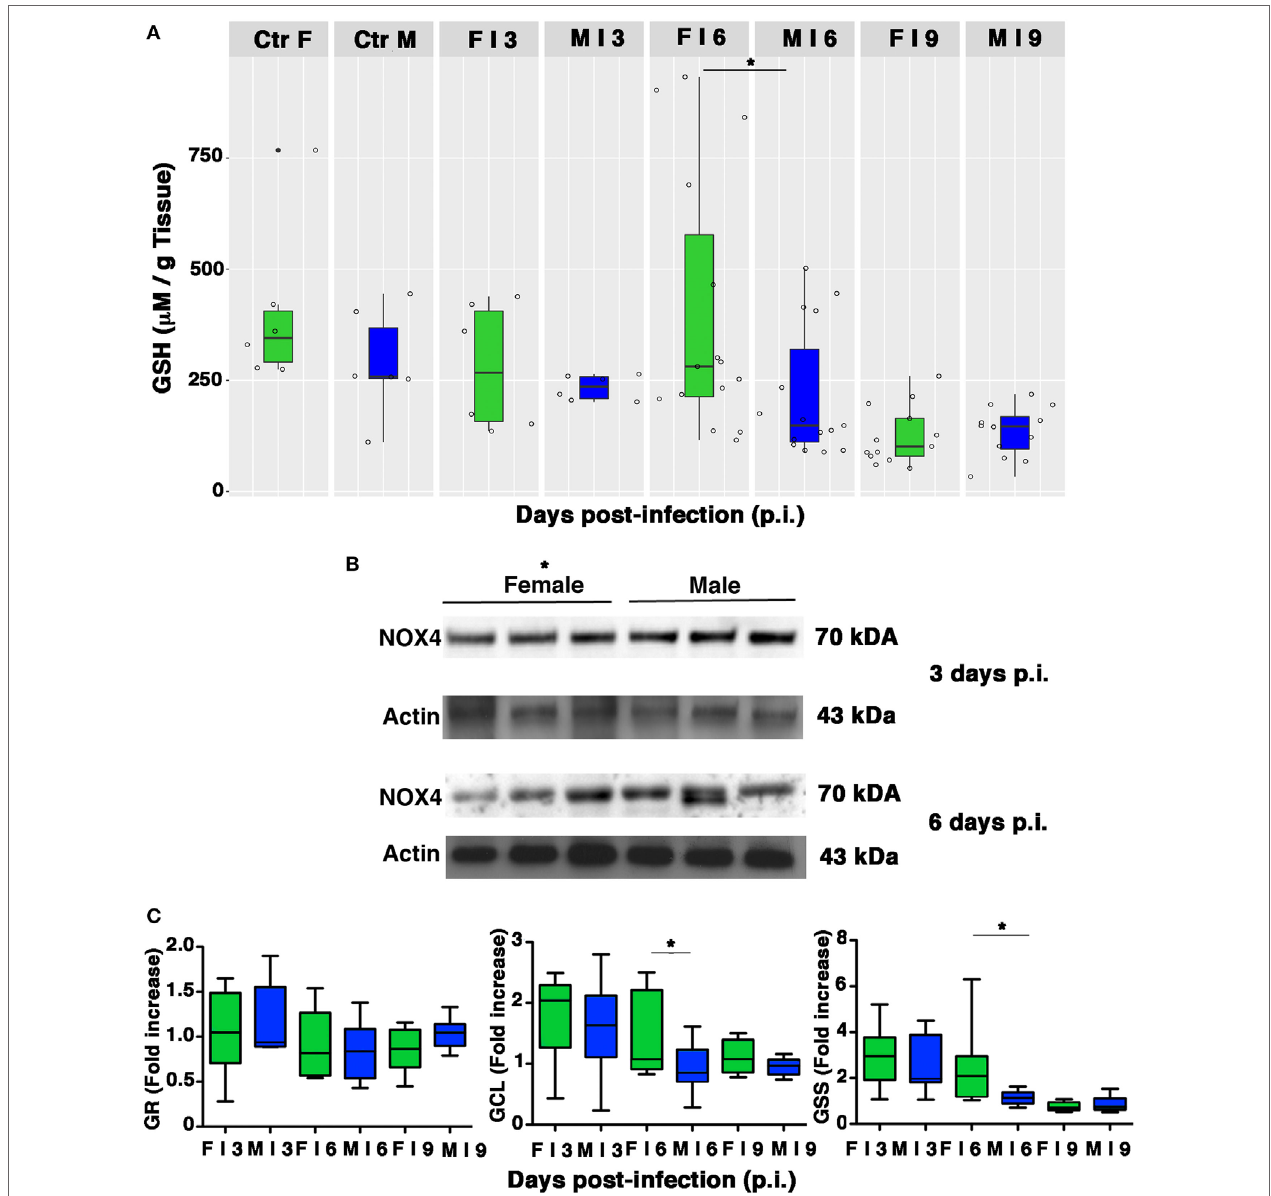
FigUre 7 | Pulmonary intracellular reduced glutathione (GSH) levels are higher in females than in males. (a) GSH content was measured in the lungs of mock- infected (Ctr) or infected (I) female and male mice sacrificed at indicated time points. Results represent data pooled from four separate experiments. In details, mock-infected mice were 12 (6/sex), infected mice on p.i. day 3 were 12 (6/sex), on p.i. day 6 were 30 (15/sex), on p.i. day 9 were 25 (13 females and 12 males) * p -value = 0.034. (B) NADPH oxidase 4 (NOX4) expression was analyzed by western blotting in the lungs of infected female and male mice. Actin was used as loading control. Blots shown are one representative experiment of three performed (three animals for each sex, * p -value ≤ 0.05). (c) RT-PCR quantification of enzymes responsible for recycling and biosynthesis of GSH [glutathione reductase (GR), glutamate cysteine ligase (GCL), and glutathione synthase (GSS)]. Gene expression was measured in lung homogenates of animals sacrificed on p.i. days 3, 6, and 9. Box-plots represent the fold increases relative to levels observed in mock-infected controls ( n = 8/sex). Unpaired t -test * p -value ≤